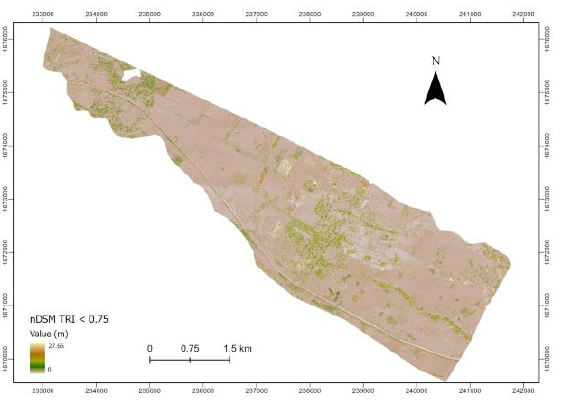
Figure 4a. TRI-filtered nDSM.